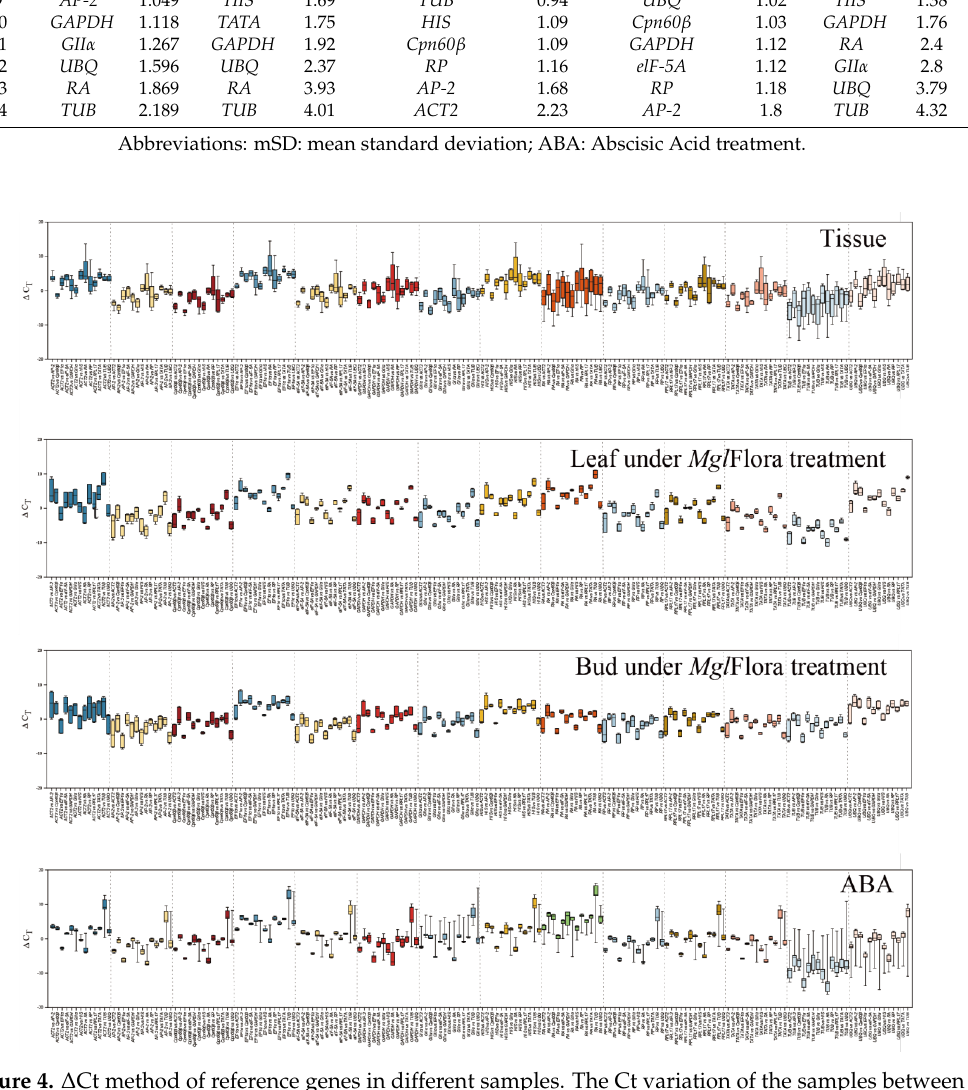
Figure 4. ∆ Ct method of reference genes in different samples. The Ct variation of the samples between different reference genes is shown in a box-whisker plots. The shorter box indicates that both genes express stably relatively, while, the longer the box indicates that more variable expression of both genes. Abbreviations: ABA: Abscisic Acid treatment.